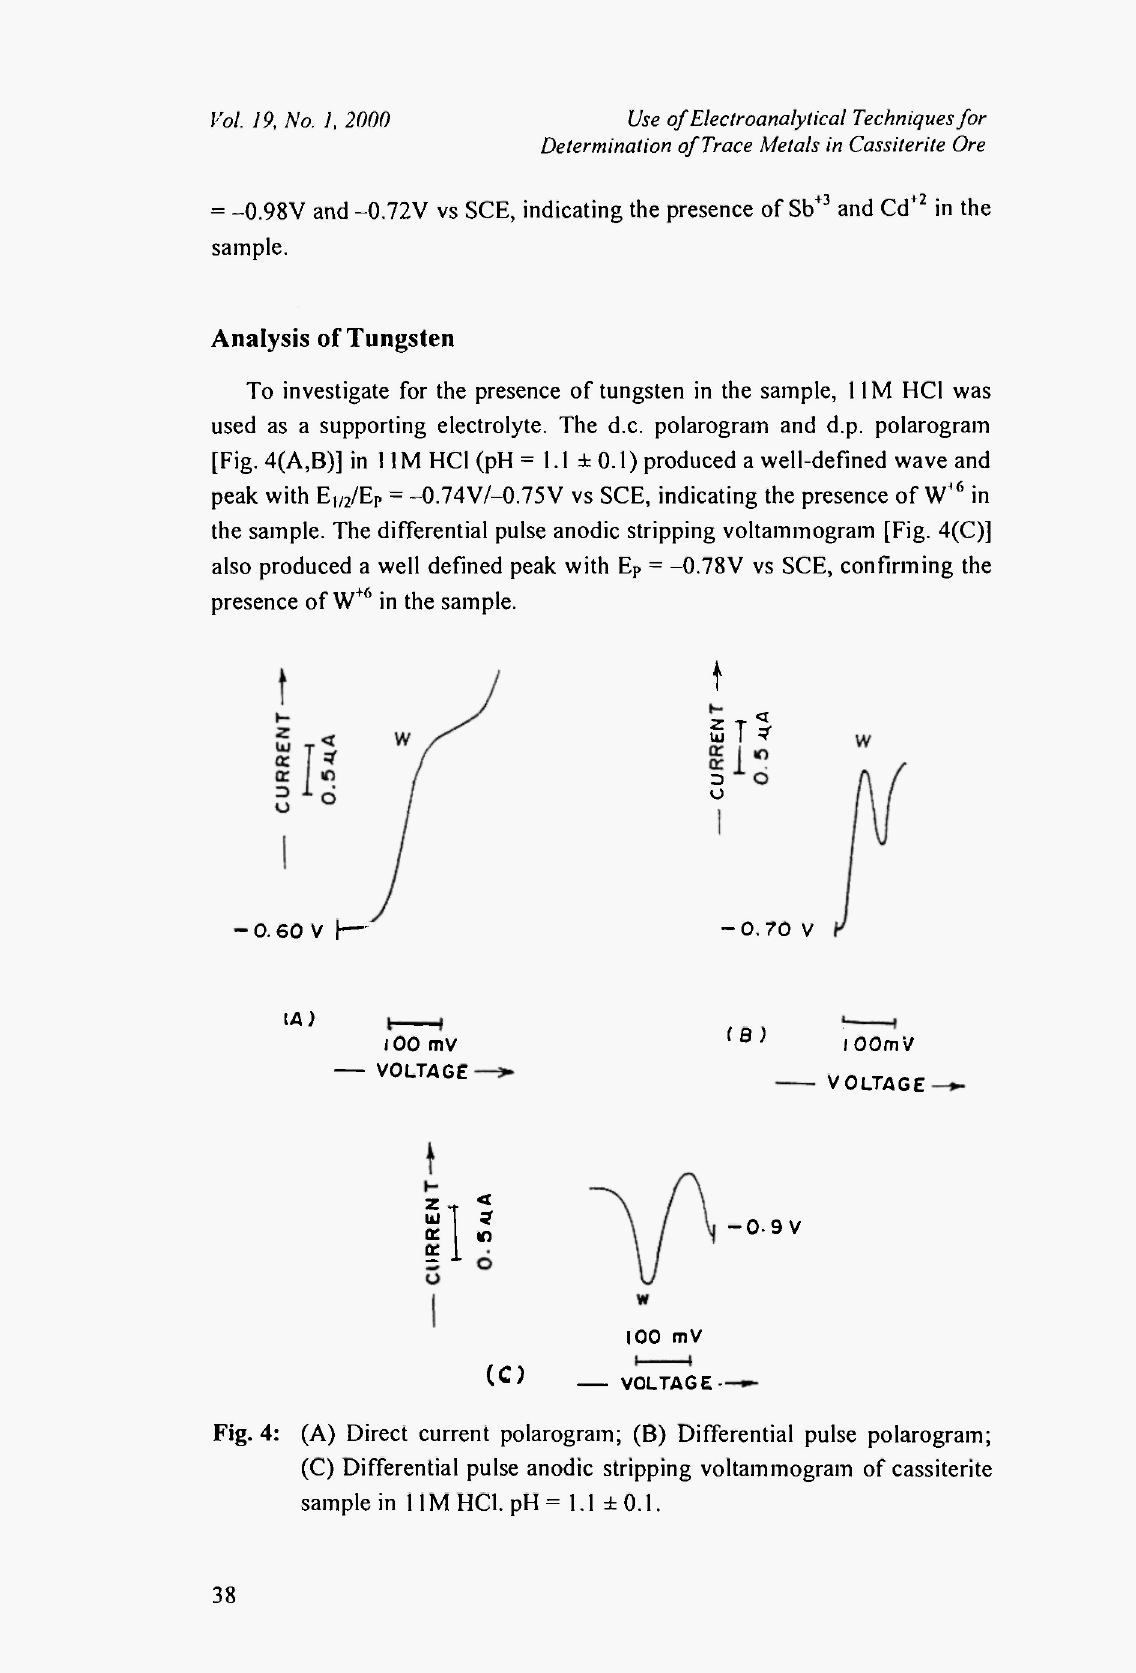
Fig. 4: (A) Direct current polarogram; (B) Differential pulse polarogram; (C) Differential pulse anodic stripping voltammogram of cassiterite sample in 11MHC1. pH= 1.1